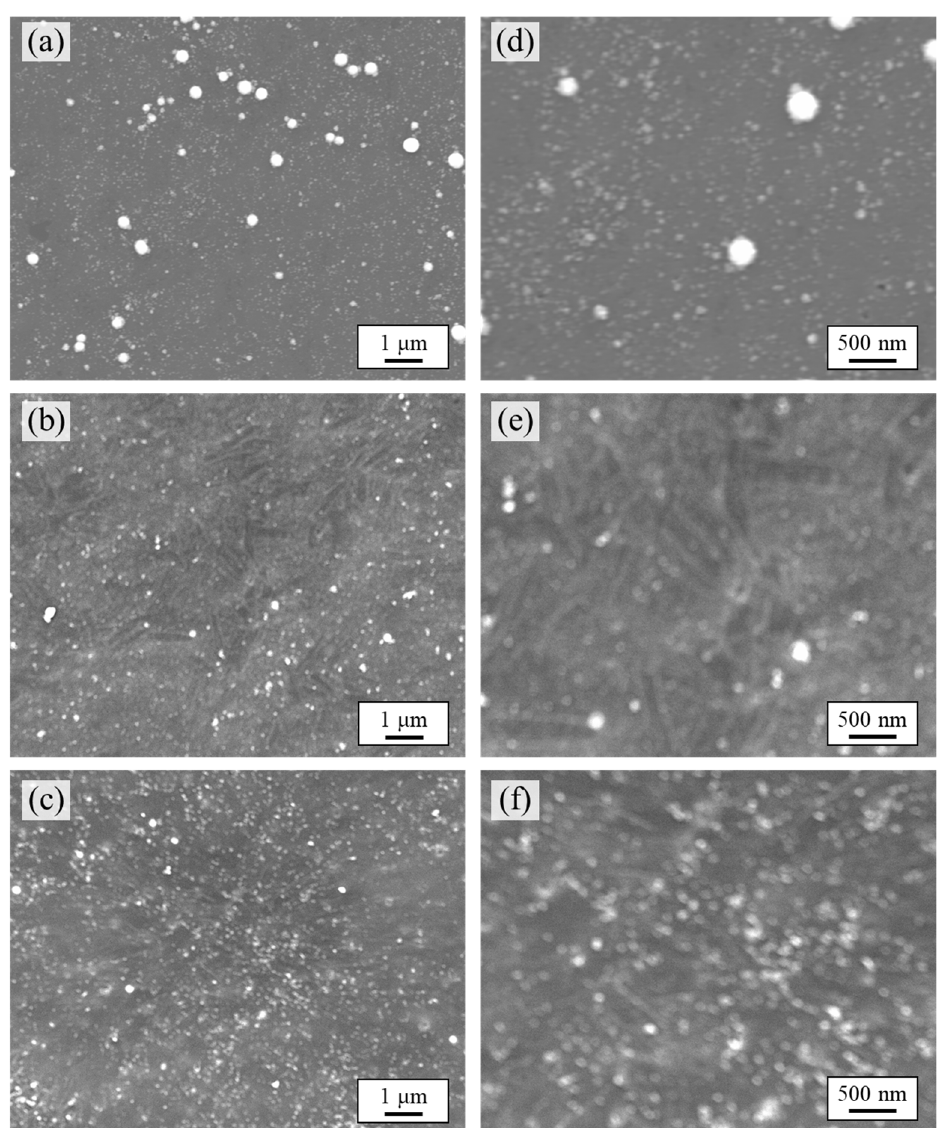
Figure 1. SEM images of Pd/ABS: ( a – c ) low-magnification SEM images of Pd/ABS 0 vol%, Pd/ABS 1 vol%, and Pd/ABS 10 vol%; ( d – f ) high-magnification SEM images of Pd/ABS 0 vol%, Pd/ABS 1 vol%, and Pd/ABS 10 vol%.